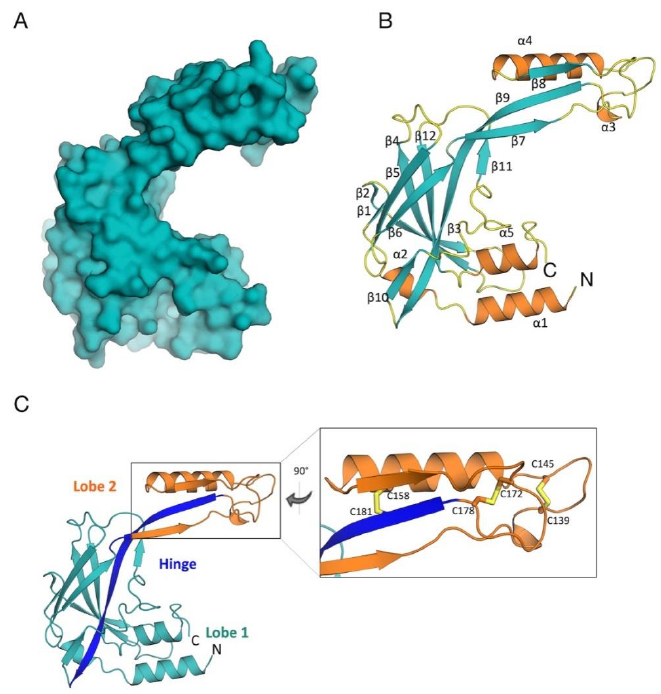
Figure 1. 3D structure of Tc SMP. ( A ) Surface representation, illustrating the “C-shaped” organization of Tc SMP. ( B ) Cartoon, secondary structure representation of Tc SMP ( β -strands in teal, α -helices in orange, 3-, 4-, and 5-turns and loops in yellow). The N and C-termini are indicated. ( C ) Stereo view of the Tc SMP crystal structure. Tc SMP is structurally organized into two lobes (colored in teal and orange), connected by a hinge portion, constituted by a β -strand and a connecting loop, depicted in blue. A detailed view of the region of lobe 2 that hosts the three disulfide bonds (sticks) is shown. This figure was generated using CCP4mg [54].